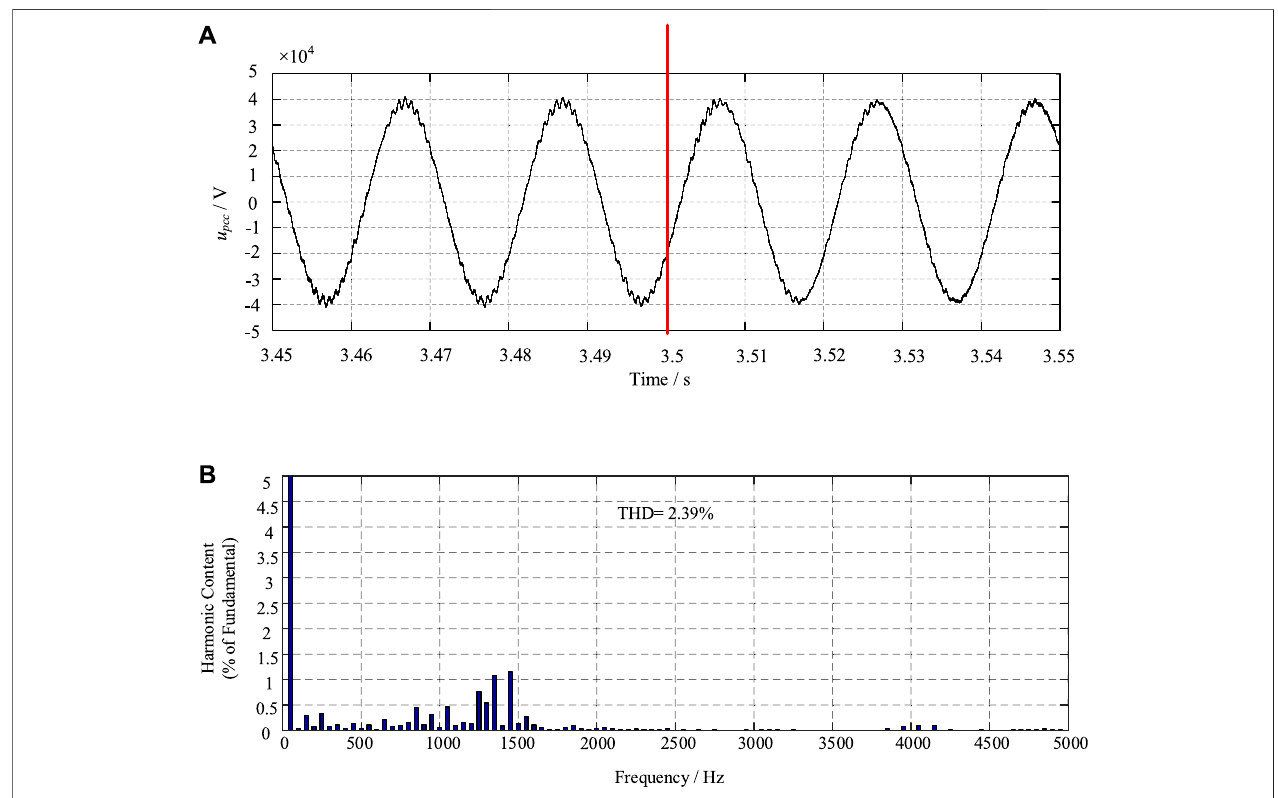
FIGURE 11 | The simulated waveforms and the harmonic spectra for case II (A) voltage of the PCC, (B) harmonic spectra of u PCC .